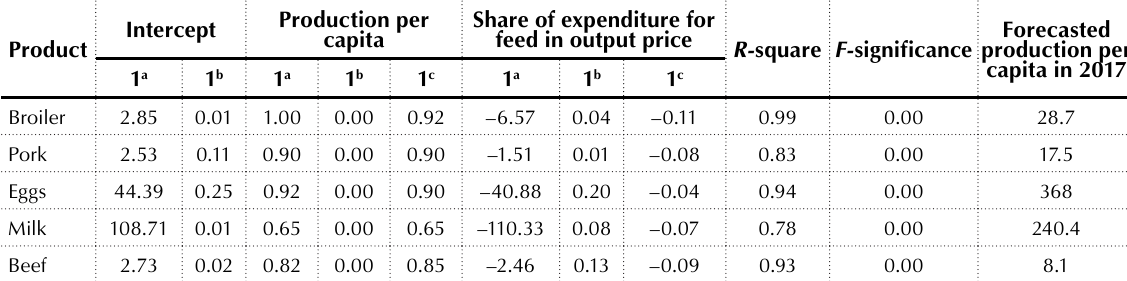
Source: Calculated by the